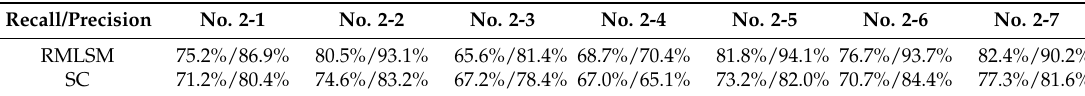
Table 4. Comparative matching accuracy between the RMLSM and the shape context (SC).